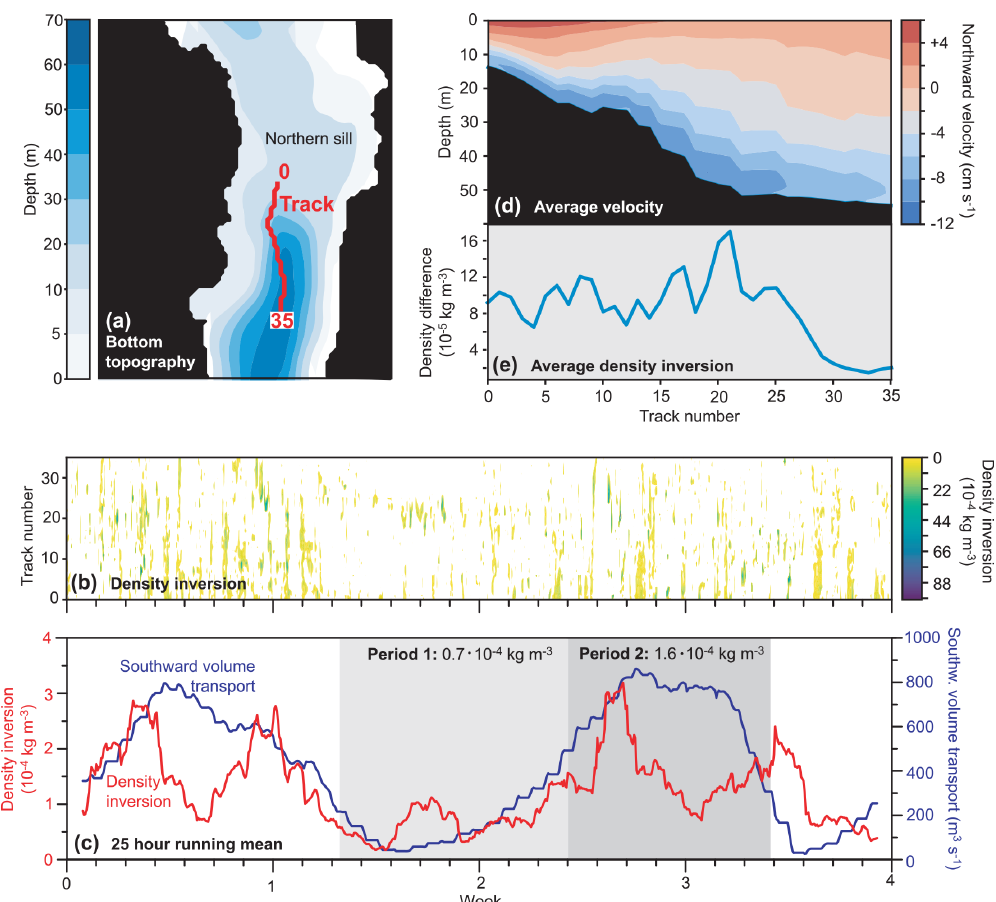
Figure 11. (a) Bottom topography around the northern sill. The red line shows a track with numbers ranging from 0 to 35, which are used in the other panels. (b) Density inversion, defined as density ( σ θ ) difference between the deepest layer and two layers above (layer 2 minus layer 0) along the track every hour. Only positive values are shown (negative values white). (c) The red curve shows the density inversion in the panel just above averaged over all track numbers and 25h running mean. The blue curve is 25h running mean of southward-directed volume transport (positive towards the south) across the northern sill (set to zero for hours with northward transport). The shaded areas indicate the two periods defined in Fig. 7 with average density inversion for each period shown. (d) Average northward velocity at various depths along the track. (e) Density inversion along the track averaged over the whole